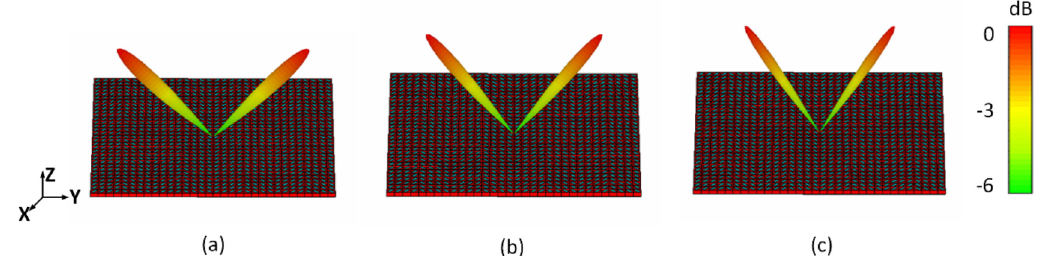
Fig. 5. Normalized E-pattern of Metasurface I at (a) 1.30 THz, (b) 1.50 THz, (c) 1.70 THz when the chemical potential is